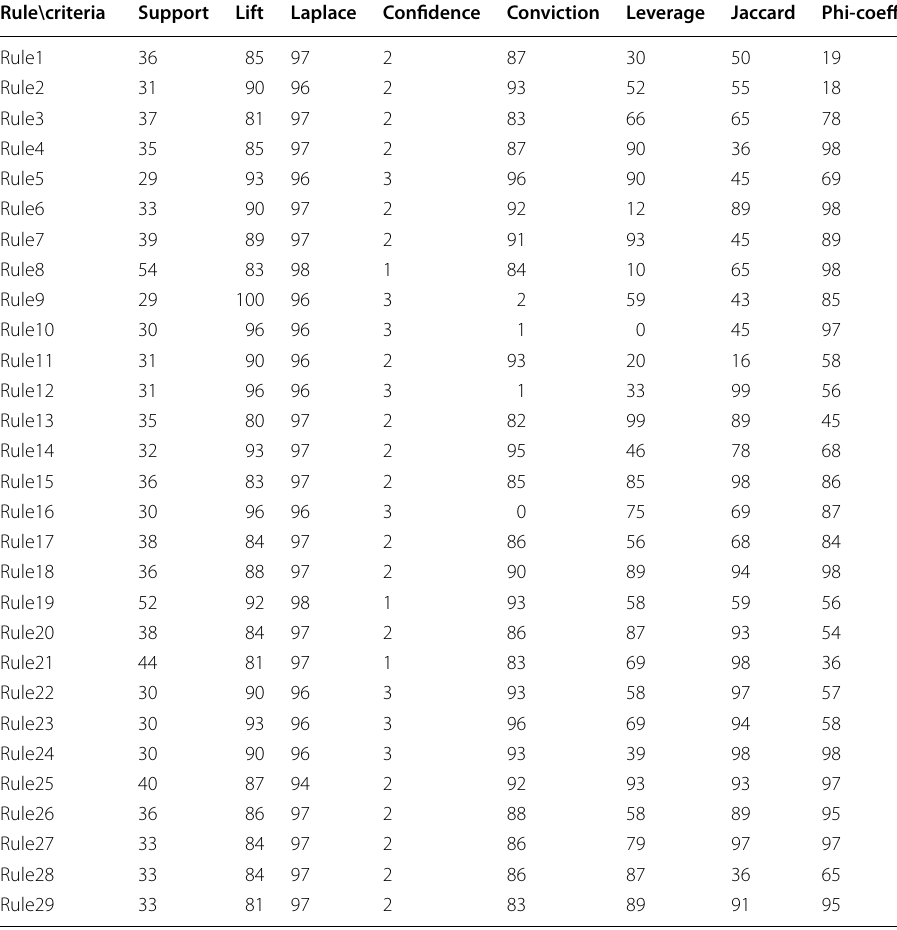
Table 7 Evaluation table